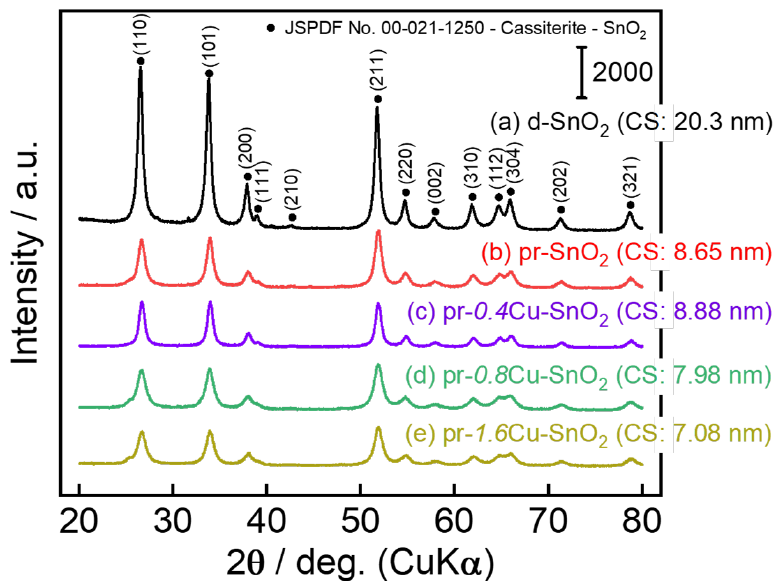
Figure 4. XRD patterns of d-SnO 2 , pr-SnO 2 , and pr- w Cu-SnO 2 ( w : 0.4 , 0.8 , 1.6 ) powders.